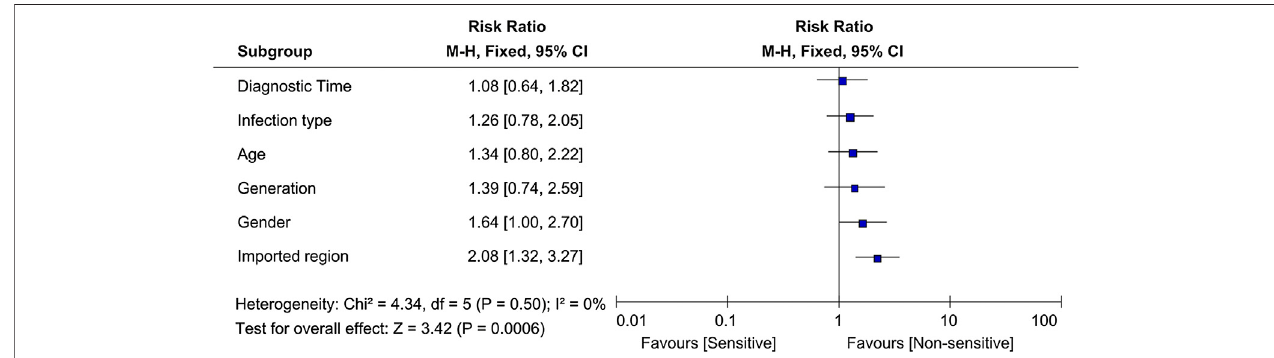
FIGURE 2 | Subgroup analyses of therapeutic ef fi ciency through age, gender, infection type, generation, imported region, and diagnostic time in 59 cured COVID-19 patients. Dashed vertical line corresponds to zero heterogeneity of the therapeutic effect. The variables were compared as follows: age, > 46 years vs ≤ 46 years; gender, female vs male; infection type, local transmission vs imported; generation, G2-3 vs G0-1; imported region, other regions vs Wuhan; and diagnosis time, > 1 vs. ≤ 1